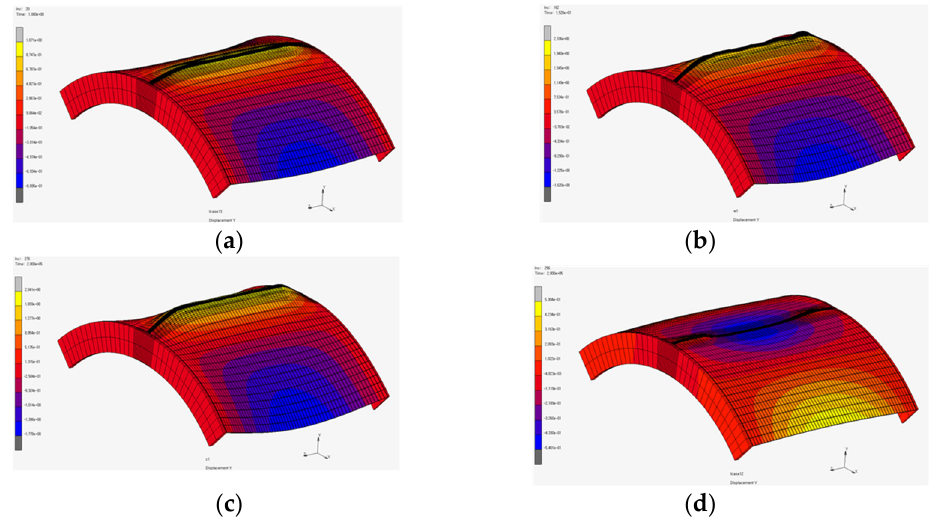
Figure 14. Welding deformation at tensile stress of 100 MPa during: ( a ) forced displacement; ( b ) welding; ( c ) cooling after welding; ( d ) when forced displacement is removed [27].